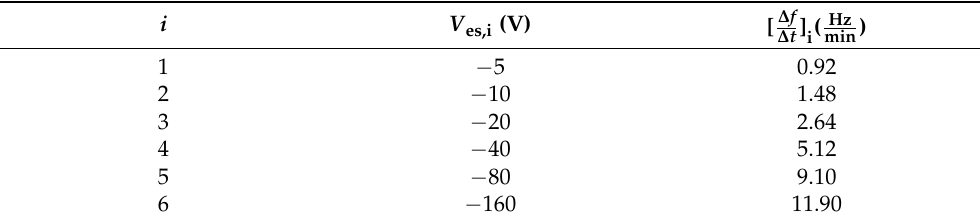
Table A5. Numbering and values of sampling voltage for determination of sampling efficiency of the MEMS-DMPS using FEM and for experimental particle sizing using the inversion